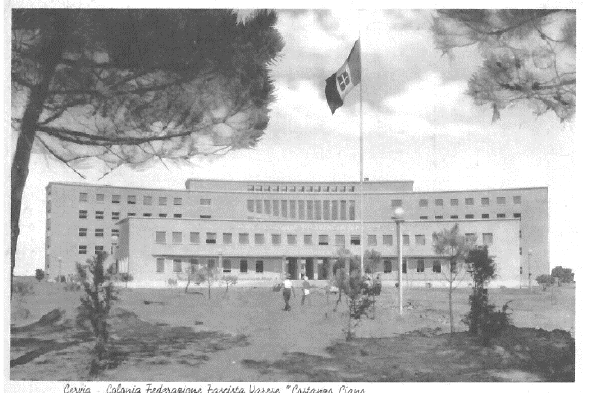
Figure 3 . Varese Colony in 1940.